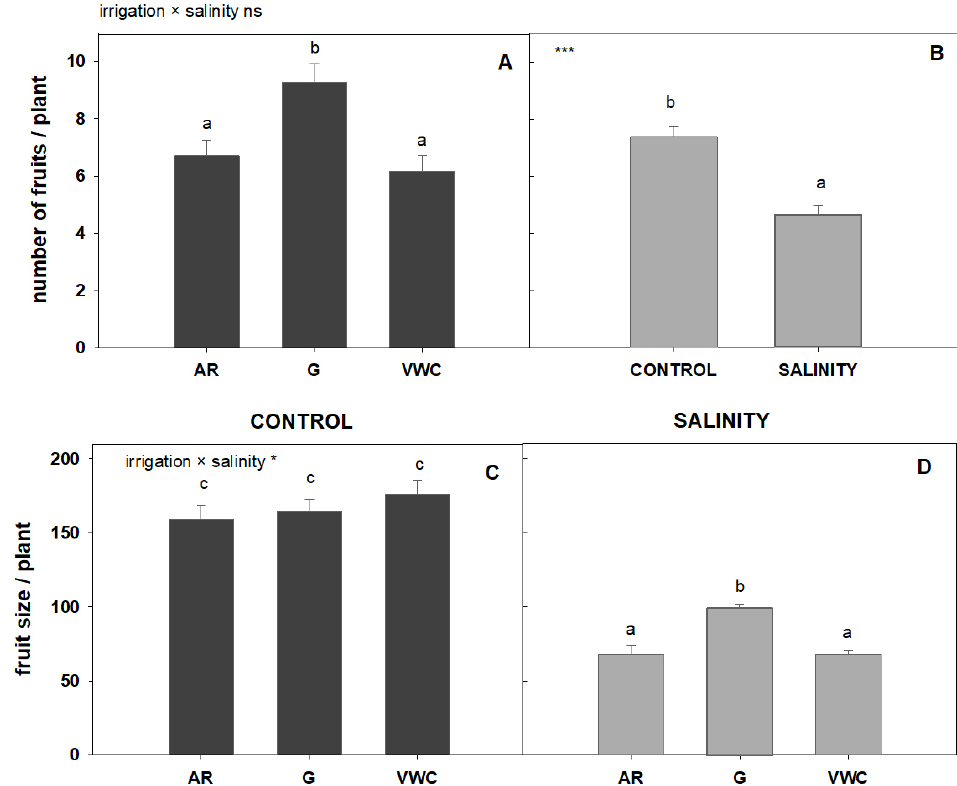
Figure 6. Average commercial number of fruits per plant ( A , B ) and average commercial fruit size ( C , D ), according to water quality and the irrigation used. The error bar indicates the standard error of the mean (( A ) n = 48; ( B ) n = 72; ( C ) and ( D ) n = 24). Top left in this Figure means: “ns” indicates non-significant differences, * indicates significant differences at p < 0.05, and *** at p < 0.001. Values with different letters are significantly different at 95%, according to Duncan’s multiple range test.